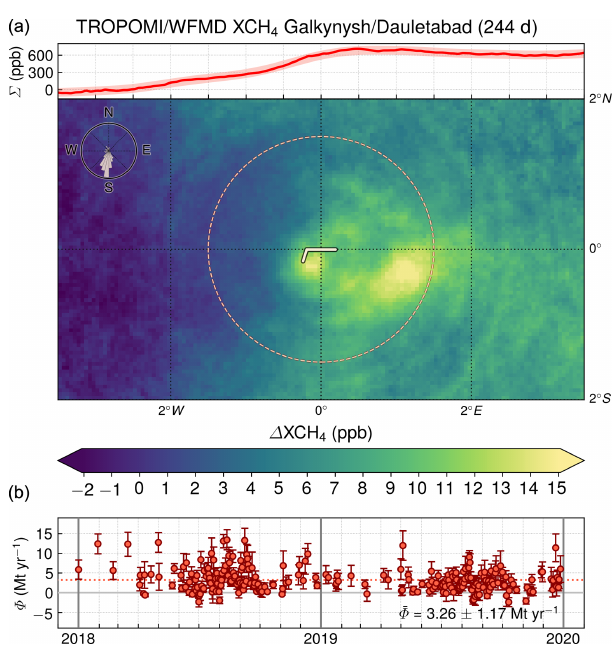
Figure 11. As Figs. 4, 5, 7, 8, and 10 but for the Galkynysh and Dauletabad fields in Turkmenistan. The coordinates of the pivotal point are 37 . 25 ◦ N, 62 . 2 ◦ E.